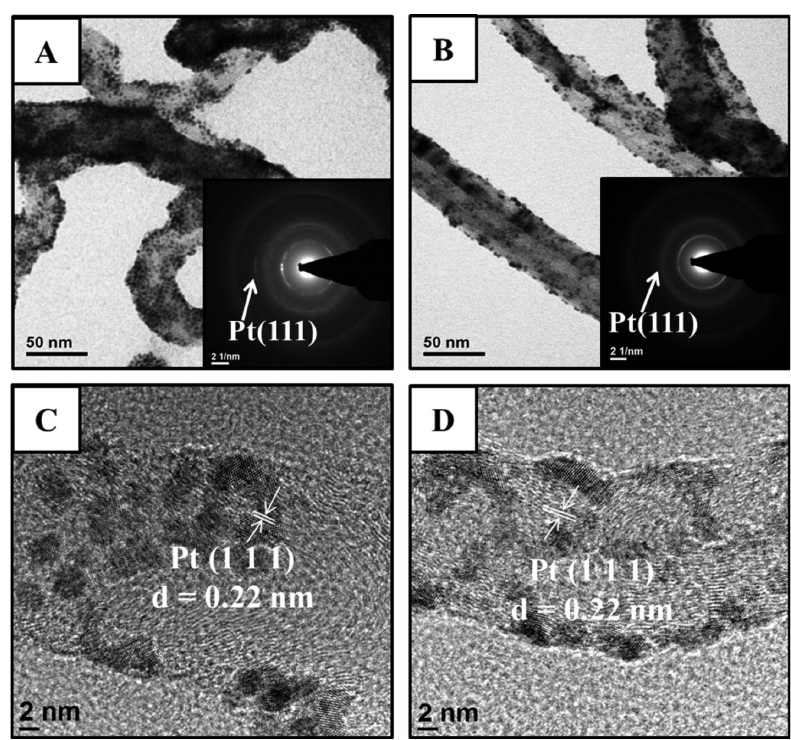
Figure 1. TEM images (A and B) and HRTEM images (C and D) of Pt/[BMIM][PF 6 ]/CNT and Pt/[BMIM][Cl]/CNT nanohybrids. Inset to (A) and (B): their corresponding SAED